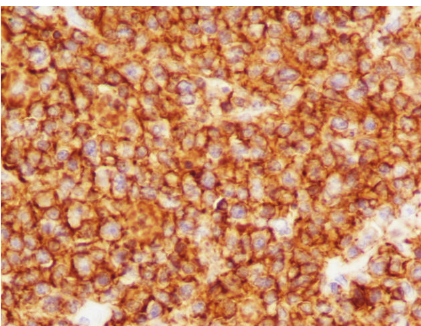
Figure 4: Positive CD20 (immunohistochemistry, original magni- fication ×